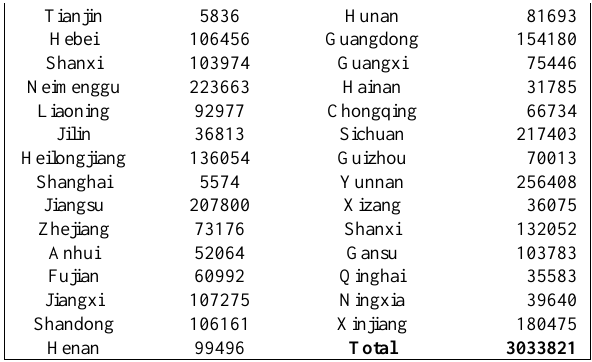
Table 2: Sample counts of China RSAIS samples across 31 provinces